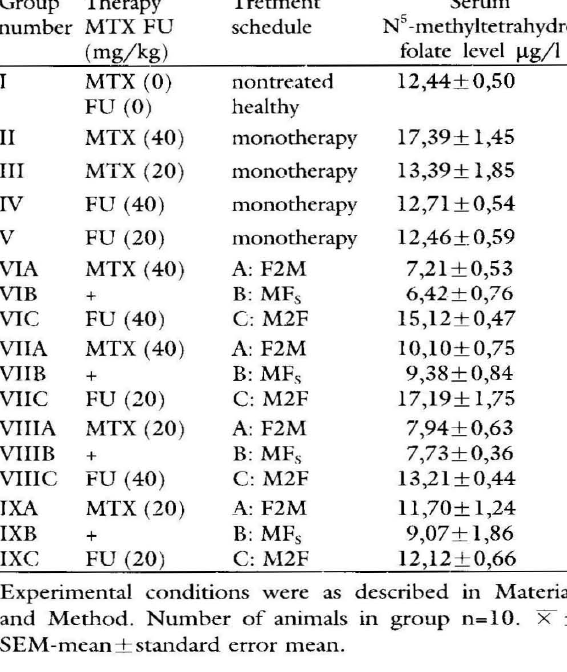
Table 6. Statistically significant differences of serum cyano cobalamine levels between the groups of EDF, mice with LI210 leukemia after administration of MTX, FU and combined therapy with both drugs according to different schedules